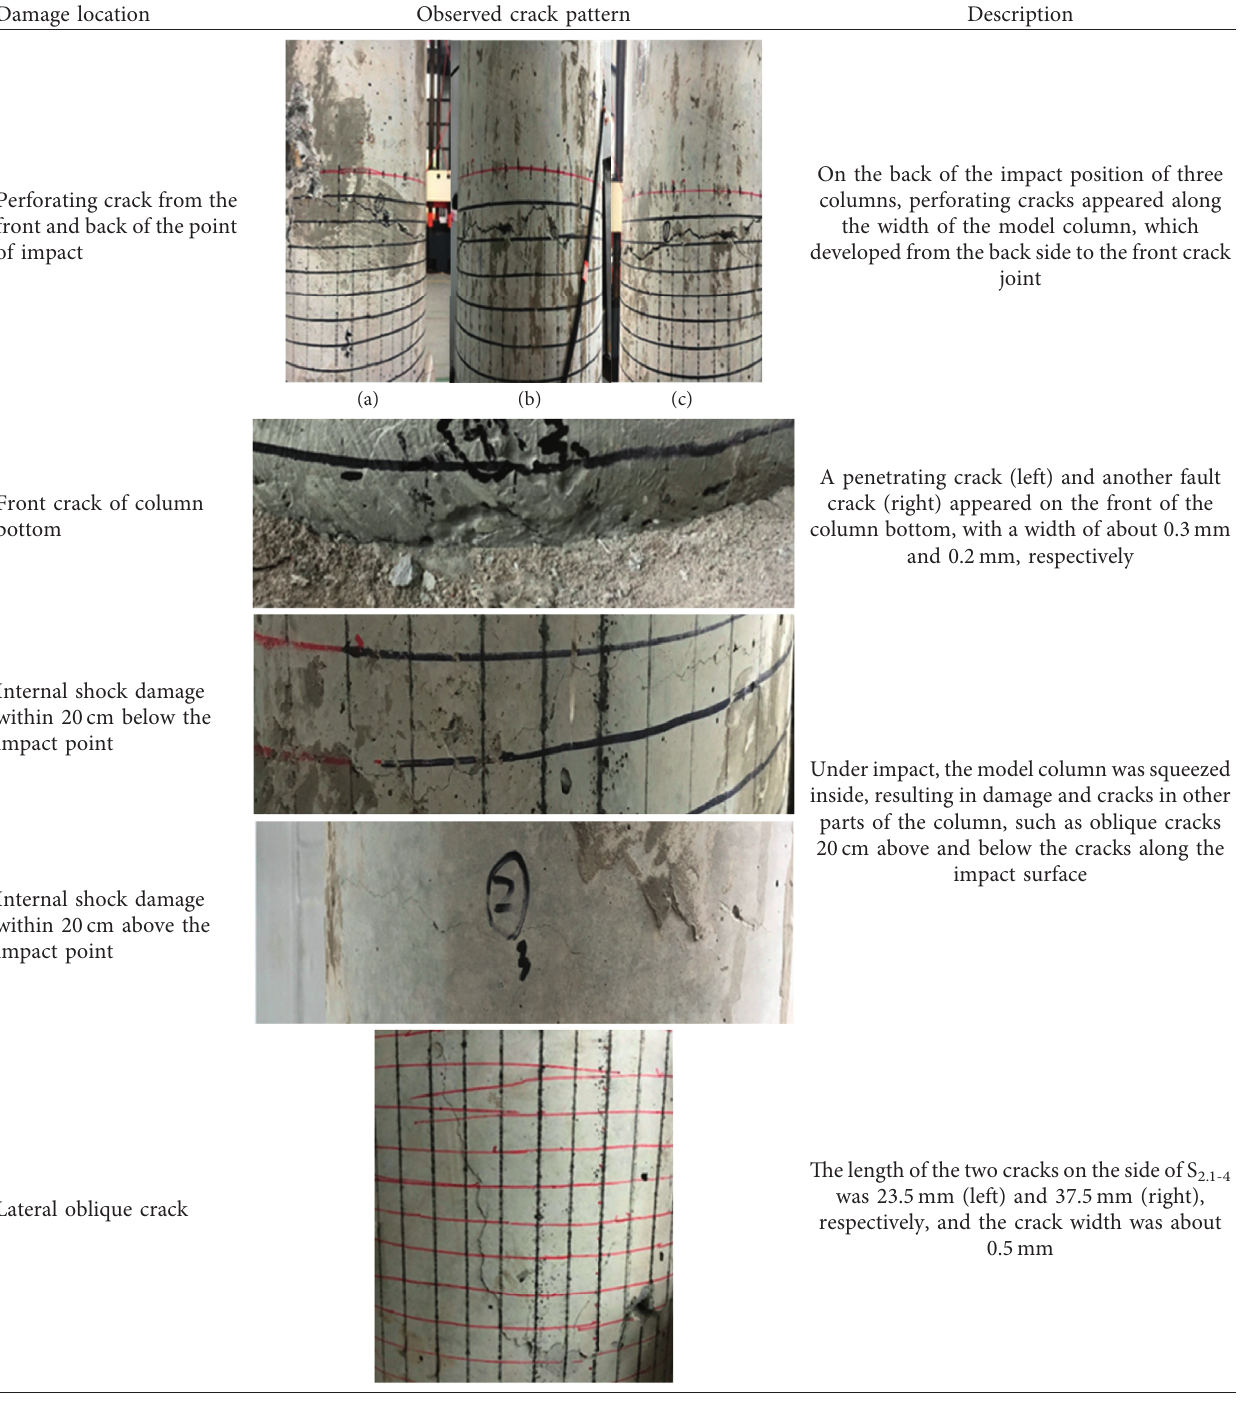
Table 7: Description of different